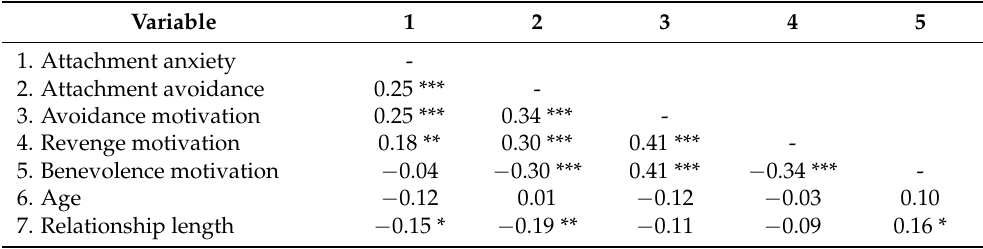
Table 1. Correlations for study variables and potential covariates.